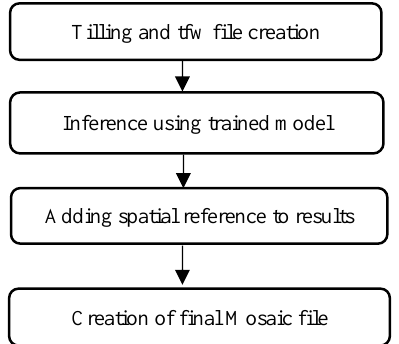
Figure 7 Processing steps of test phase of the model